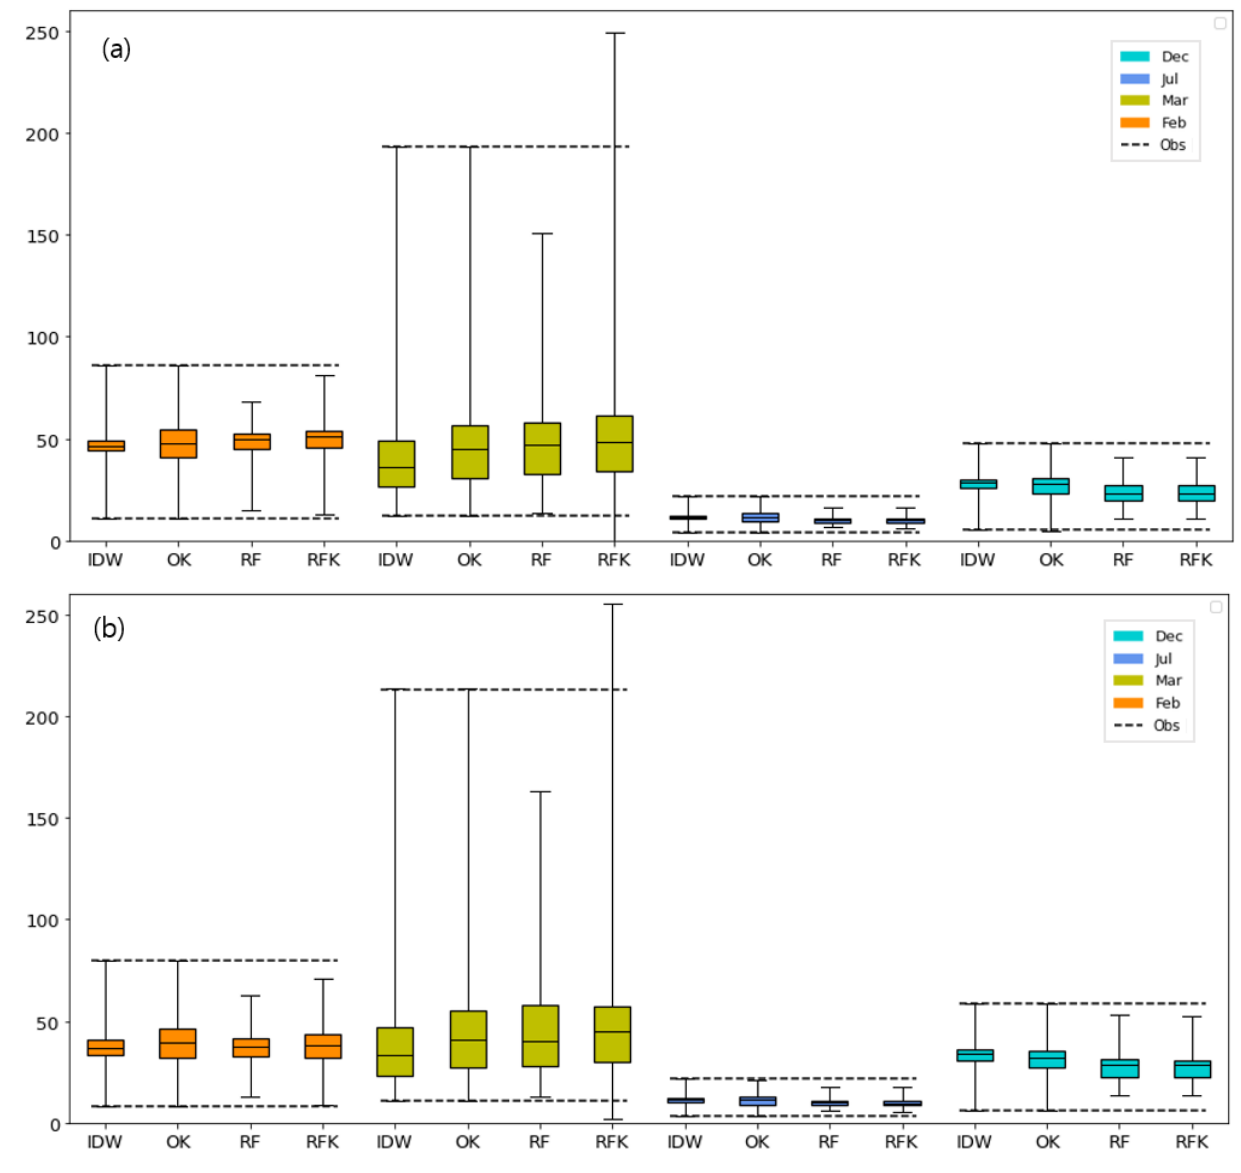
Figure 9. Box plots of data distribution of observations and estimates from four models with ( a ) monthly and ( b ) 10-day datasets. IDW, OK, RF, and RFK indicates inverse distance weighted, ordinary kriging, random forest, and random forest blended with ordinary kriging, respectively.